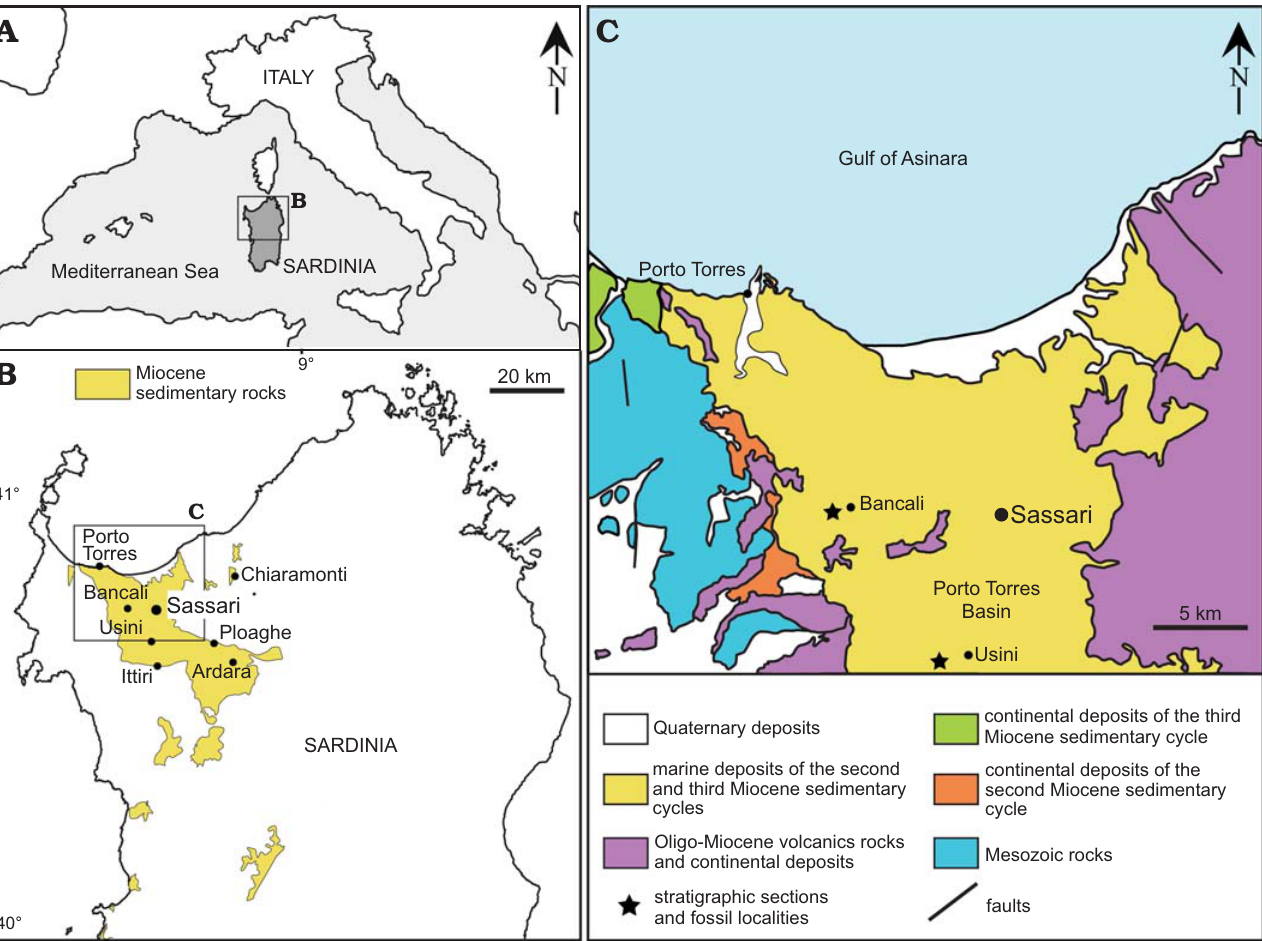
Fig. 1. A . Map of the Mediterranean showing location of studied area B . Distribution of Miocene sedimentary rocks in northern Sardinia and location of echinoid assemblages cited within the text. C . Simplified geological map of the northern part of the Porto Torres Basin with the location of the clypeast- eroid-echinoid assemblages of Bancali and